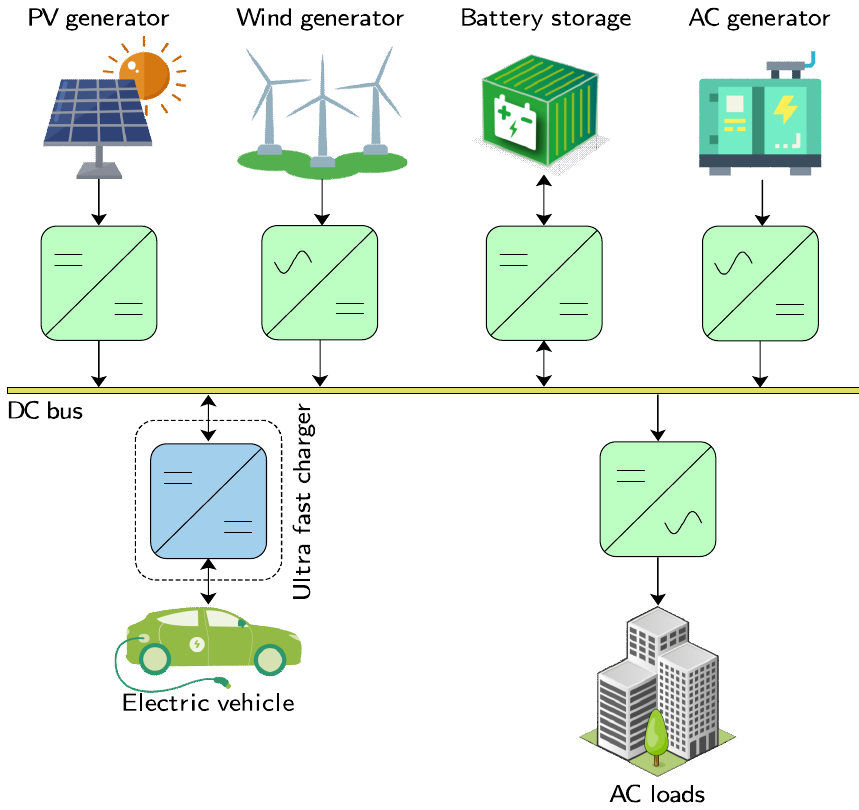
Figure 15. The ultra-fast charging station in DC standalone microgrid.